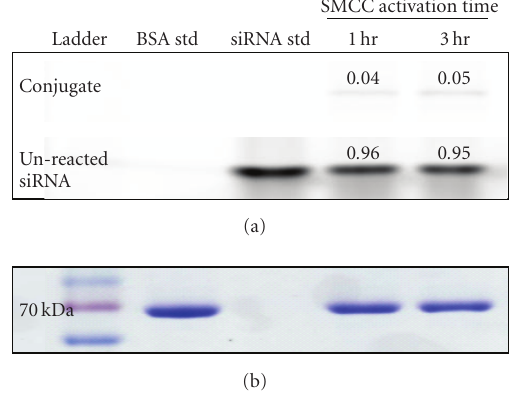
Figure 2: Ine ffi cient conjugation using amine-modified siRNA without prior ultrafiltration to remove ammonium